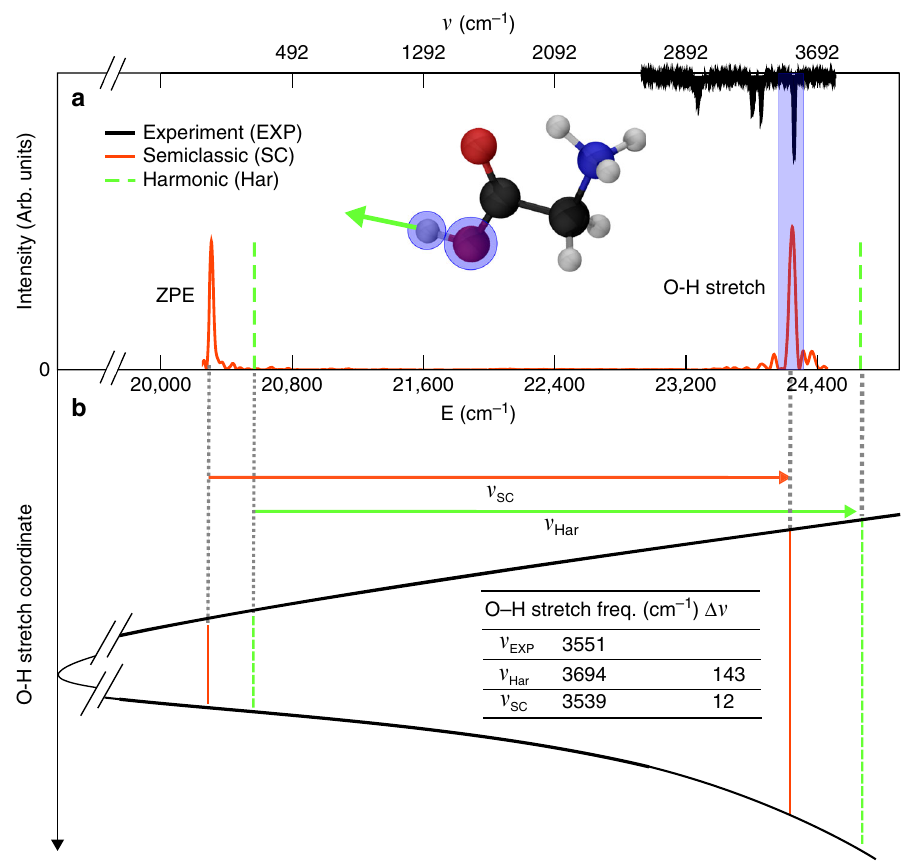
Fig. 1 Vibrational power spectrum of the protonated glycine molecule. a GlyH + vibrational spectrum. Red continuous line is the semiclassical power spectrum, and green dashed lines correspond to the stick spectrum in the harmonic normal mode approximation. The peak intensity of the power spectra has been scaled to match the semiclassical ZPE peak one. Black continuous line is the experimental IR absorption spectrum 69 . In the same panel, ball-and- stick molecular representation of GlyH + at the equilibrium C s geometry where the atoms involved in the O – H stretch normal mode displacements are highlighted. b Pictorial representation of the potential well along the O – H stretch elongation. Red and green lines are respectively the semiclassical and the harmonic ZPE and O – H stretch excitation vibrational levels. Red and green arrows are respectively the semiclassical and the harmonic normal mode O – H stretch fundamental excitation frequencies. These values are reported in the inset table together with their deviations from the experimental value ( Δν